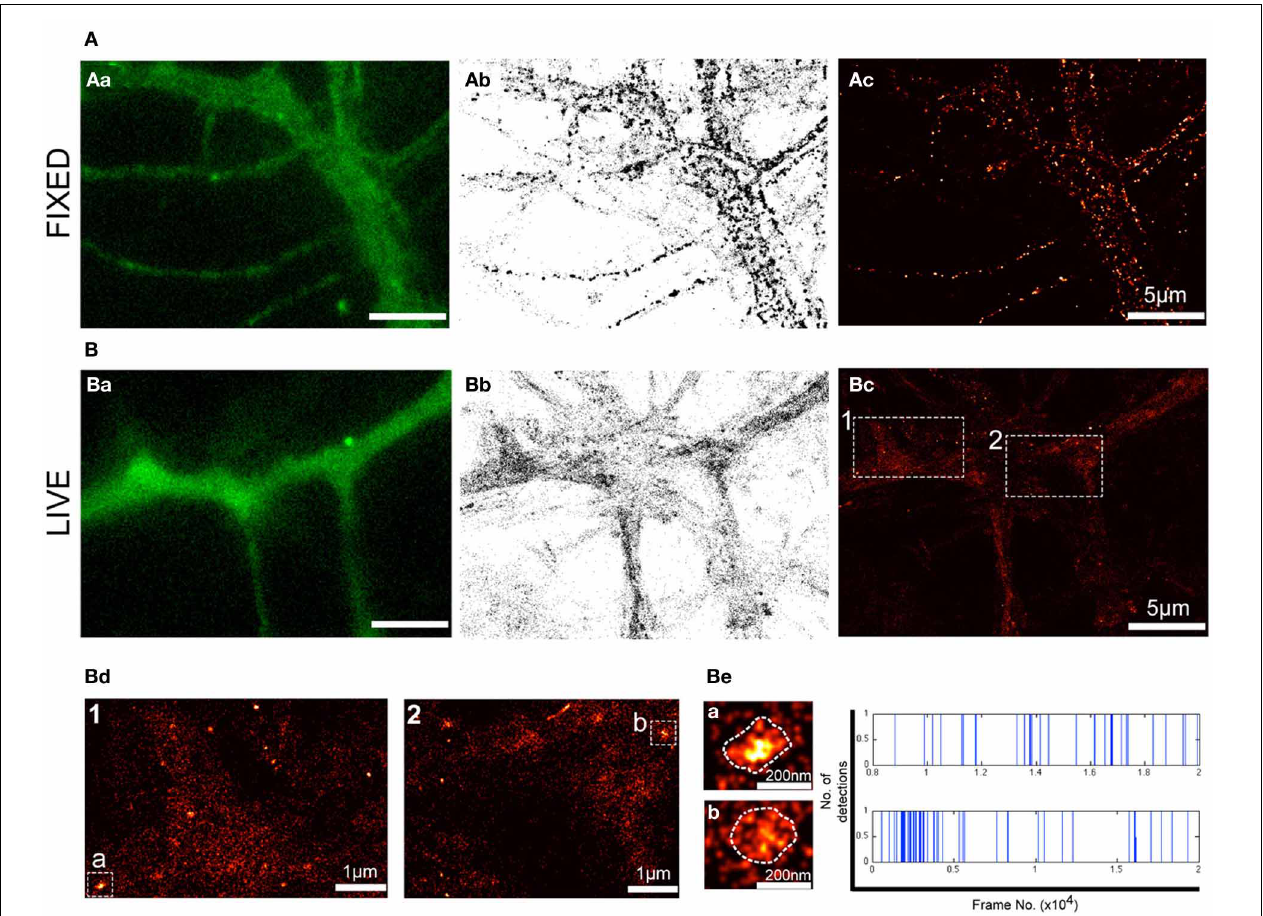
FIGURE 2 | PALM reveals nanoclusters of P2X7Rs. PALM imaging was performed on live (A) and fixed (B) neurons transfected with P2X7-Dendra2. (Aa,Ba) Representative fluorescent images of a section of dendrite before PALM imaging was performed. (Ab,Bb) Pointillist images displaying all detections obtained for P2X7-Dendra2. (Ac,Bc) Super-resolved rendered image generated with a pixel size of 5nm. Note fixation-induced clustering in